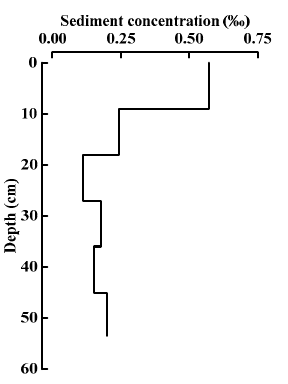
Figure 10. Vertical profiles of ice sediment concentration from Site A.